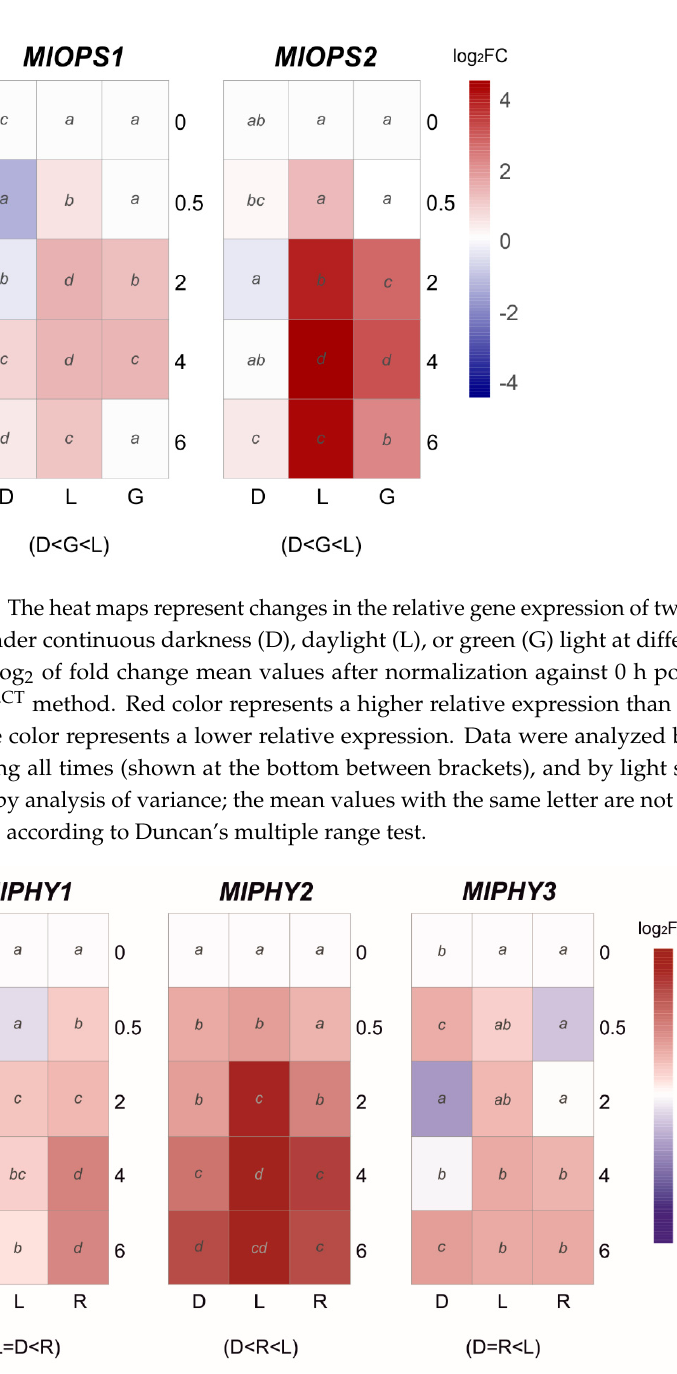
Figure 7. The heat maps represent changes in the relative gene expression of three phytochromes ( PHY ) coding genes under continuous darkness (D), daylight (L), or red (R) light at different time points. The scale is log 2 of fold change mean values after normalization against 0 h post illumination using the 2 − ∆∆ CT method. Red color represents a higher relative expression than 0 h post illumination, and blue color represents a lower relative expression. Data were analyzed between light sources containing all times (shown at the bottom between brackets), and by light source between times (letters) by analysis of variance; the mean values with the same letter are not significantly different ( p ≤ 0.05) according to Duncan’s multiple range